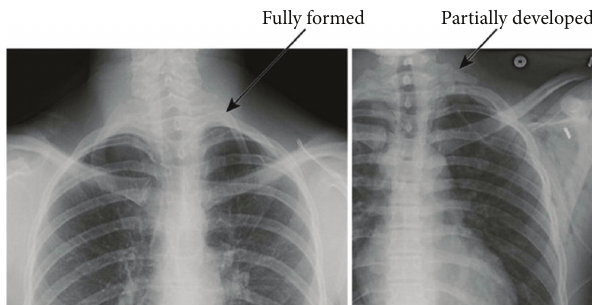
Figure 2: Radiographs show both a fully formed and a partially developed cervical rib (reprinted with permission of Elsevier; see